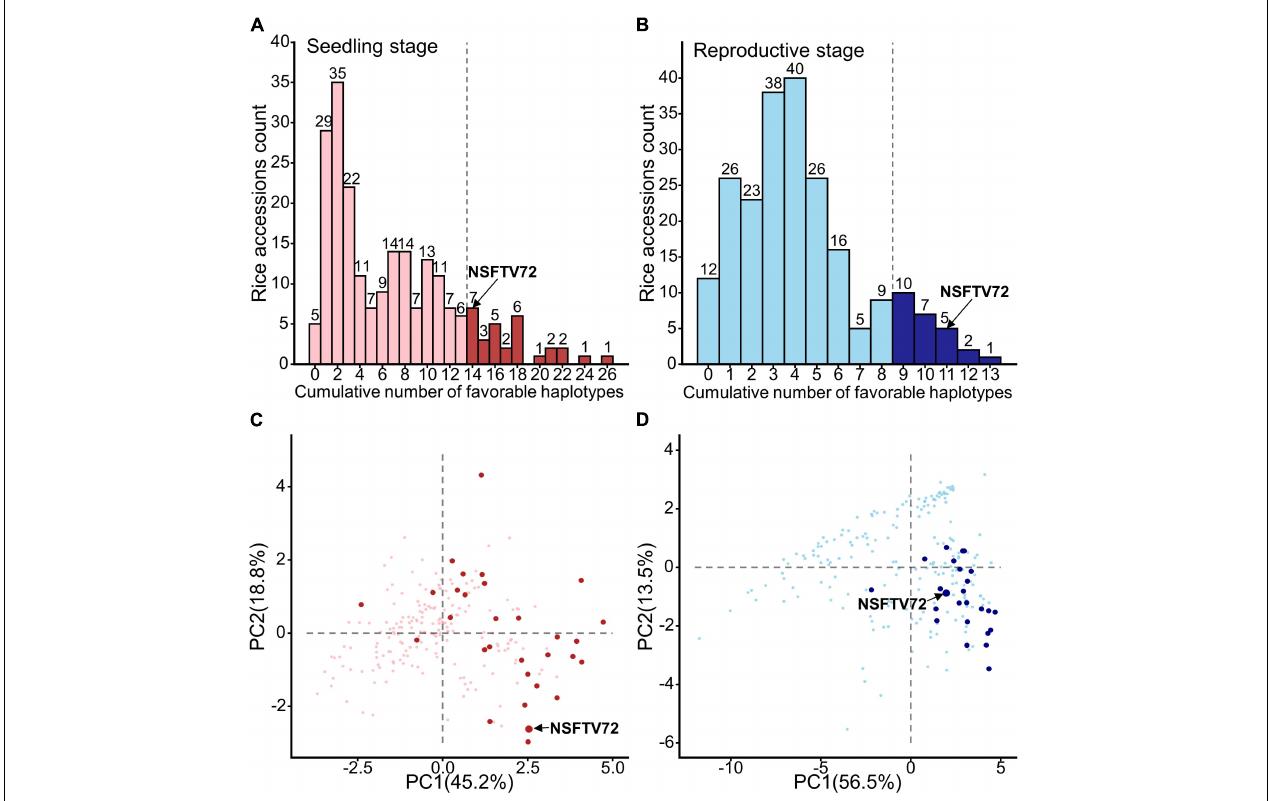
FIGURE 3 | Distribution of accessions contained low frequency favorable alleles and the potential donor germplasms of these alleles. (A,B) The histograms for the count of rice accessions with cumulative number of favorable haplotypes at seedling (A) and reproductive (B) stages. The dark columns at the right of dotted line represent the top 15% accessions that carrying most low-frequency favorable (LFF) alleles at seedling and reproductive stages, respectively. Number on each column indicates the number of accessions containing the corresponding number of LFF alleles. (C,D) Selected donor germplasms on the PCA plots similar to Figure 1 C,D . Dark points in panels (C,D) represent the top 15% accessions that carried most LFF alleles at seedling and reproductive stages, respectively. NSFTV72 is IR8, containing 14 and 11 LFF alleles at seedling and reproductive stages,